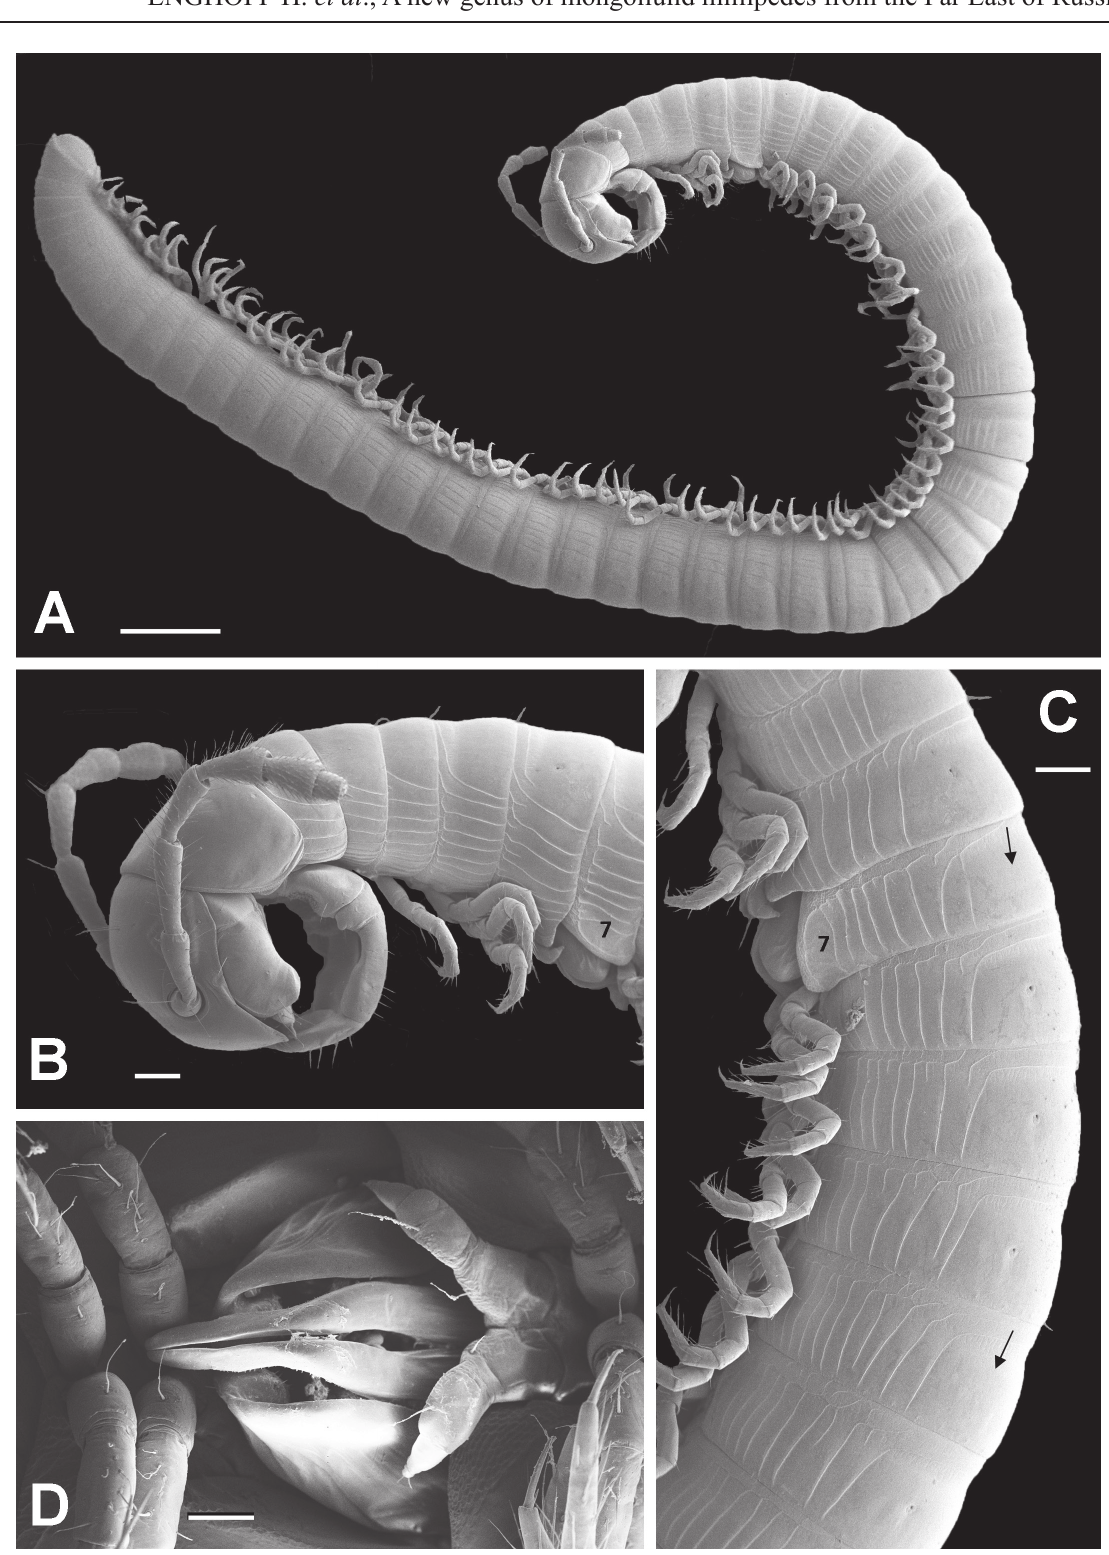
Fig. 4. Koiulus interruptus gen. et sp. nov., paratype, ♂, from the upper course of the river Ko. A . Entire body, 39 podous + 3 apodous body rings + telson. B . Anterior end. C . Body rings (5)6–12(13); note absence of ozopores on rings 7 and 11 (arrows). D . Leg-pair 7 and gonopods in situ. 7 = seventh body ring with ventral lobes. Scale bars: A =1 mm; B–C = 0.2 mm; D = 0.1